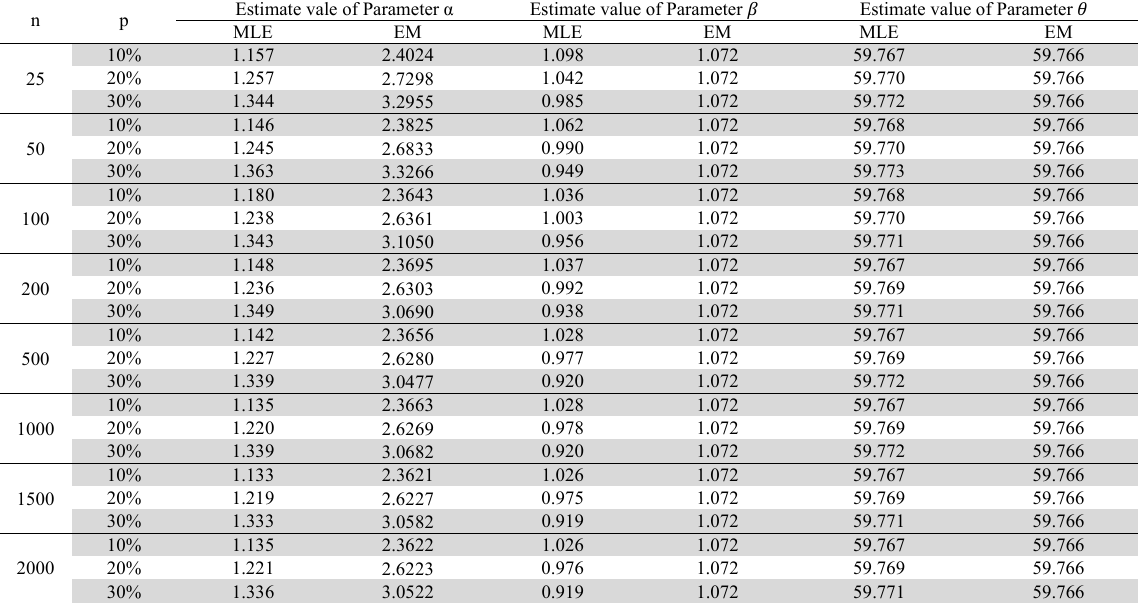
The estimate of the Parameter α , 𝛽 and 𝜃 by method MLE and EM